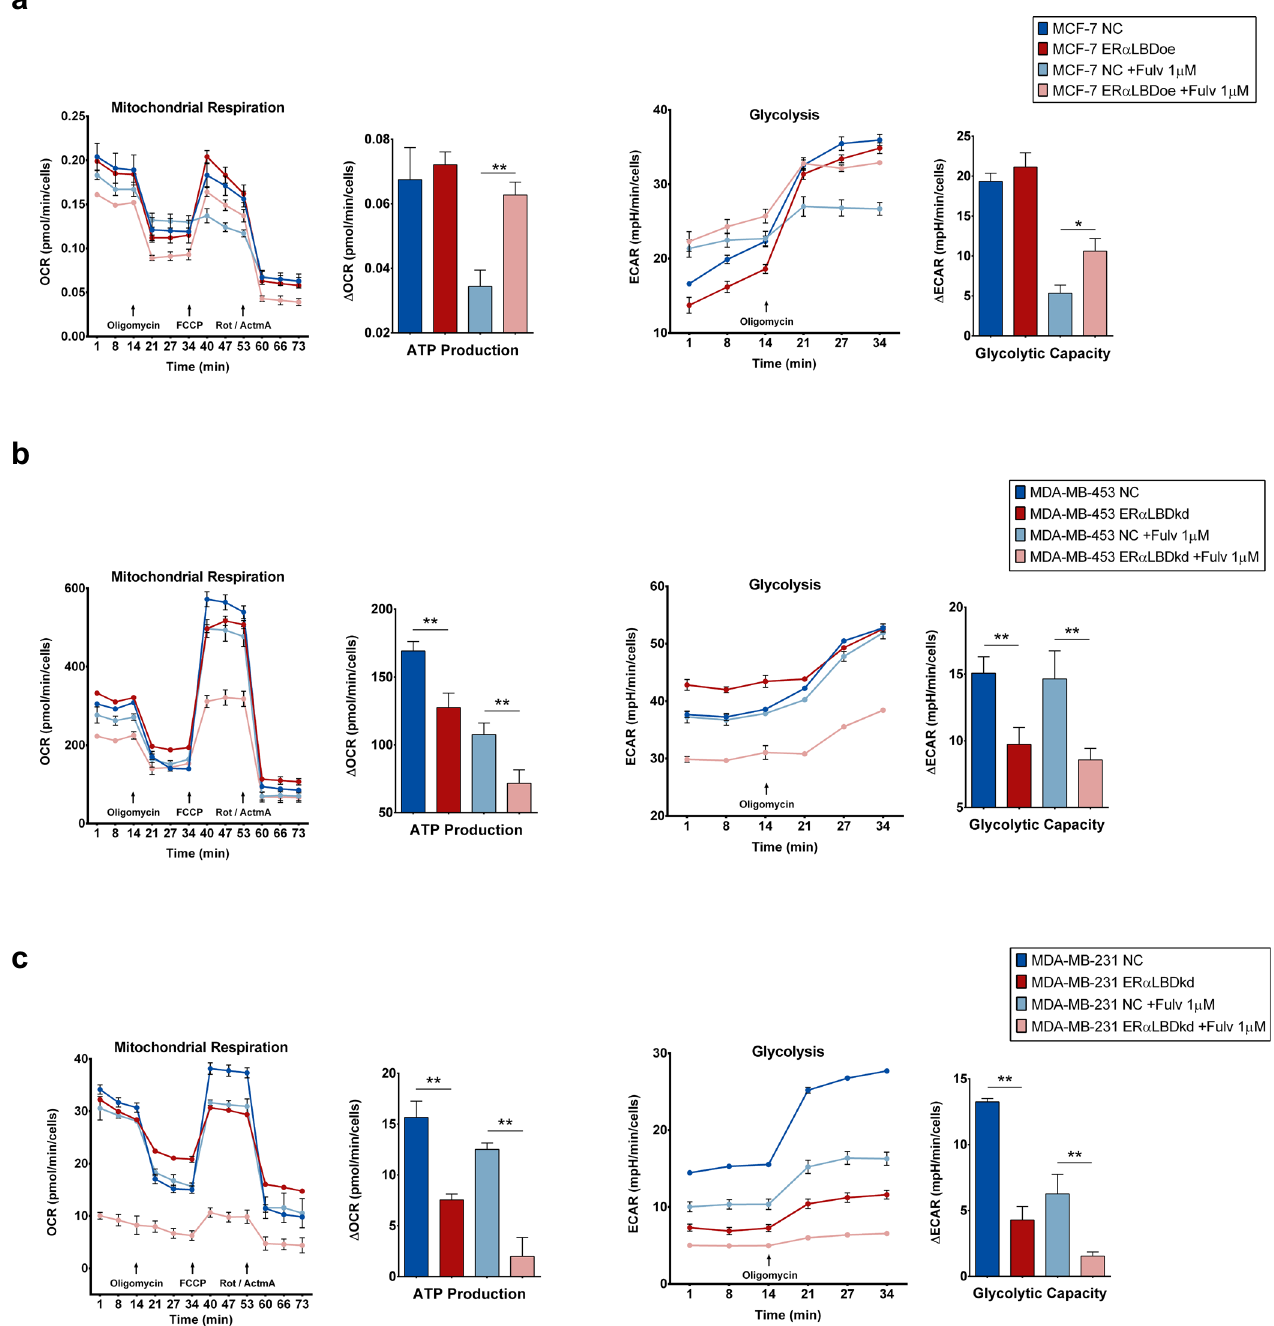
Fig. 5 Effect of ER α -LBD ‘ gain/loss-of-function ’ on BC cell metabolism. a Mitochondrial respiration and glycolysis levels in MCF-7 cell clones. Fulvestrant 1 µM (24 h pre-treatment) or vehicle (DMSO) was added to cells. ER α -LBD overexpressing (ER α -LBDoe; in dark/light red) cells were compared to controls (NC; in dark/light blue). Analyses were carried out using XF Cell Mito Stress Kit (Agilent). Respiration was evaluated as oxygen consumption rate (OCR, pmol/min), normalized on cell number. Glycolysis was evaluated as extracellular acidi fi cation rate (ECAR, mpH/min), normalized on cell number. The calculation of metabolic parameters was based on Δ OCR and Δ ECAR values, following manufacturer ’ s guidelines. b , c Mitochondrial respiration and glycolysis levels in MDA-MB-453 and MDA-MB-231 cells. Treatments as in ( a ). Cells with ER α -LBD knockdown (kd; in dark/light red) were compared to controls (NC; in dark/light blue). Analyses were carried out as described above. FCCP p-tri fl uoromethoxy-phenylhydrazone, Rot rotenone, AtmA antimycin A. Data in the fi gures are presented as mean ± s.e.m. ( n = 2 independent experiments). * P < 0.05, ** P < 0.01; unpaired t test, one-sided. Source data are provided as a Source Data fi untreated cells (Fig. 6b). Beyond the effects in ER α -FL( + ) cells, we also assessed the effects of ER α -LBD on the growth of TNBC cells. In both MDA-MB-453 and MDA-MB-231 we observed ER α -LBD knockdown to reduce cell proliferation (~50%) (Fig. 6c, d).